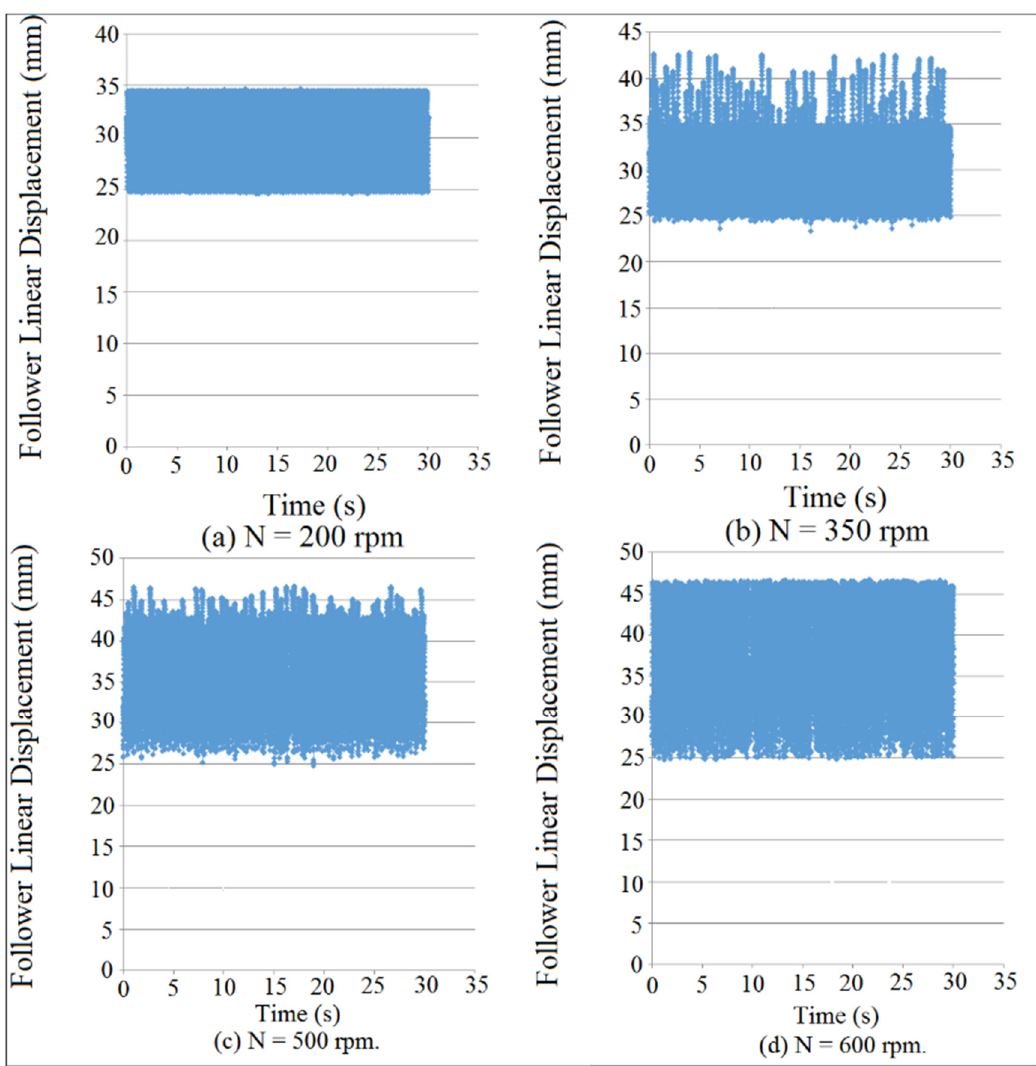
Figure 9. Follower linear displacement mapping against time for (I.D. = 17 mm).